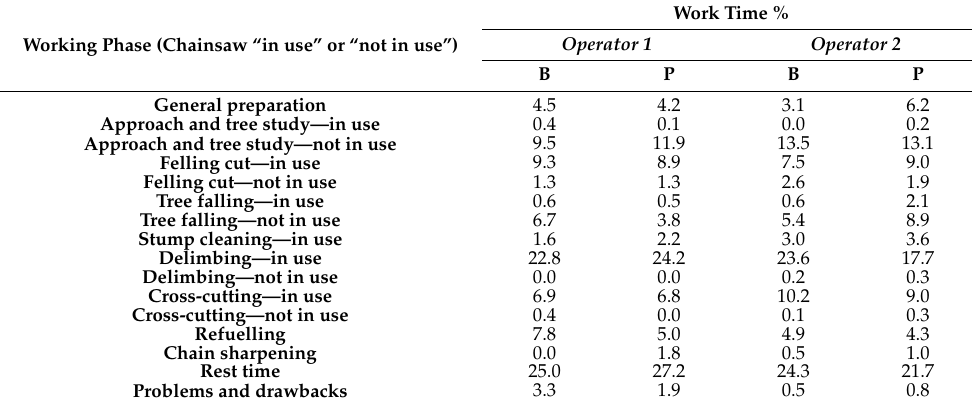
Table 4. Distribution of work time between the considered work phases (in %).